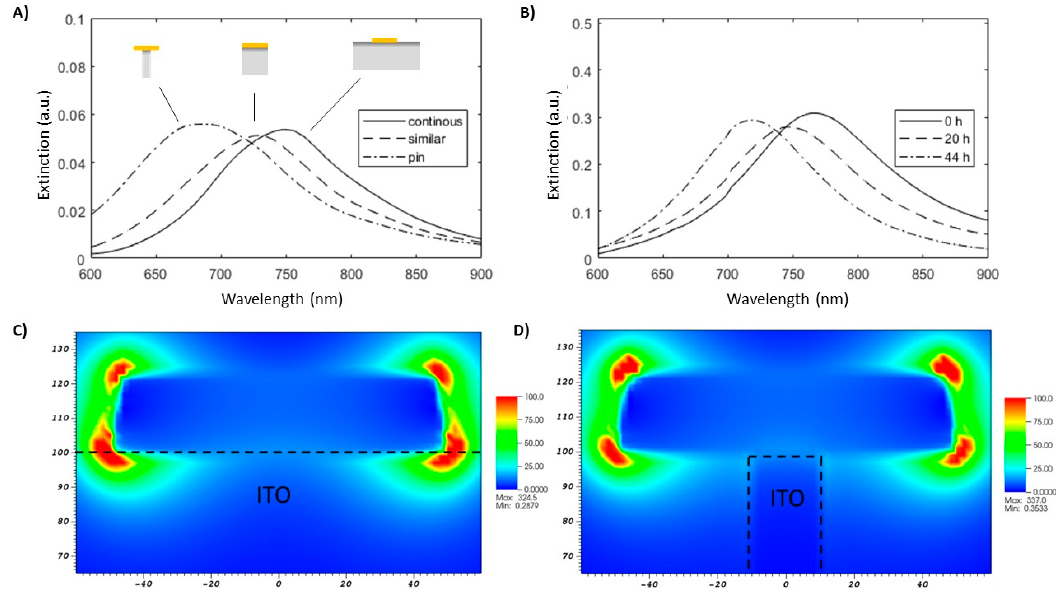
Figure 3. Extinction Spectra and plots of local electric field at resonance for metallic nanodisks supported at a layer or at a pillar of ITO. ( A ) Calculated spectra for 100 nm diameter 20 nm tall truncated cone gold nanodisks (2 nm Ti Adhesion layer) in water (n = 1.33) supported by a continuous ITO layer or by a 100 nm tall × 20 nm wide ITO pillar respectively. ( B ) Corresponding recorded experimental spectra for gold nanodisks on ITO after 0, 20, and 44 h of etching, respectively. ( C ) Calculated field enhancement at resonance for gold nanodisks on continuous ITO (C) and 20 nm wide pillars of ITO ( D ).